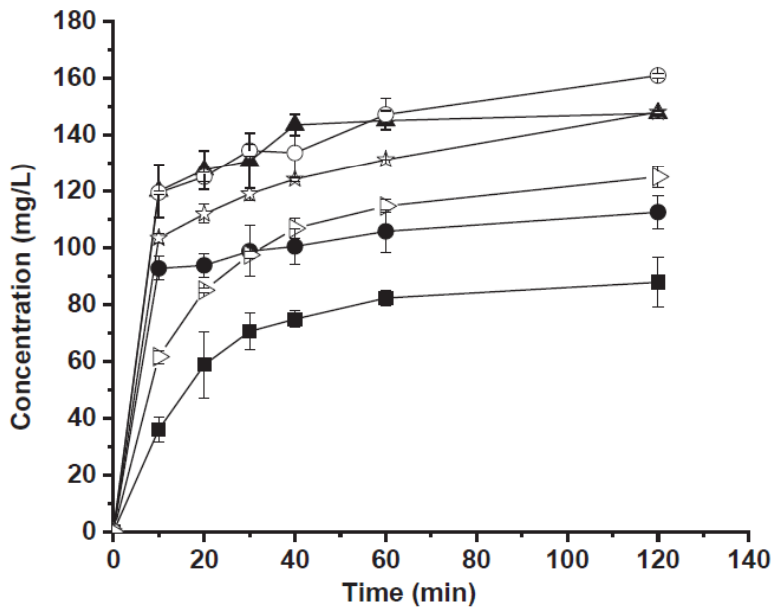
Figure 4. Carbamazepine release as a function of time from: commercial carbamazepine (full square), carbamazepine treated by ball mill (full circle), carbamazepine crystallized by antisolvent method (full triangle), physical mixture (empty triangle), carbamazepine/CaCO 3 by ball mill (empty circle) and carbamazepine/CaCO 3 by antisolvent procedure (empty stars). Reprinted with permission from Ref. [34] 2020,